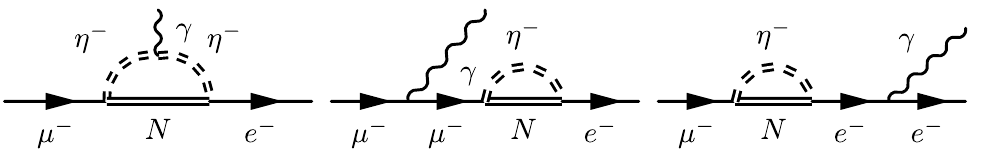
Figure 3 . DM-electron coupling (cid:21) e 1 collider, cosmological and neutrino mass constraints, but also lead to the correct relic density.